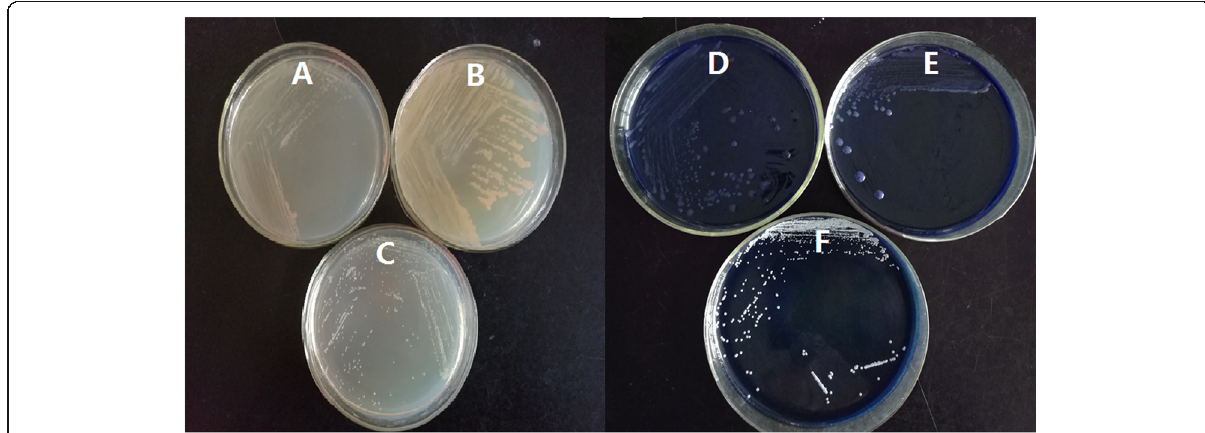
Fig. 3 EPS detection using the aniline blue staining method [9]. a , b and c strain TBZ30 T , positive control Mucilaginibacter litoreus BR-18 T and negative control Nocardioides albus KCTC 9186 T cultivated in LB plates, respectively; ( d , e and f ) the above three strains cultivated in LB-aniline blue plates,